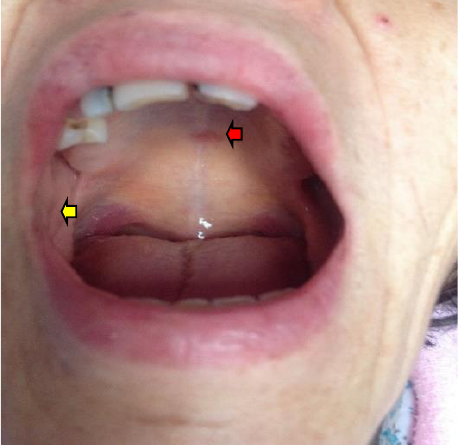
Figure 2. Young adult with Addison disease: clinical aspect of the pigmentary mucosa in the palatine arch in association with dental impressions (red arrow = pigmentary mucosa palatine, yellow arrow = dental impressions). The female patient was already diagnosed with AD with partial compliance with hormonal replacement therapy; oral manifestations were registered while she was under endocrine surveillance.